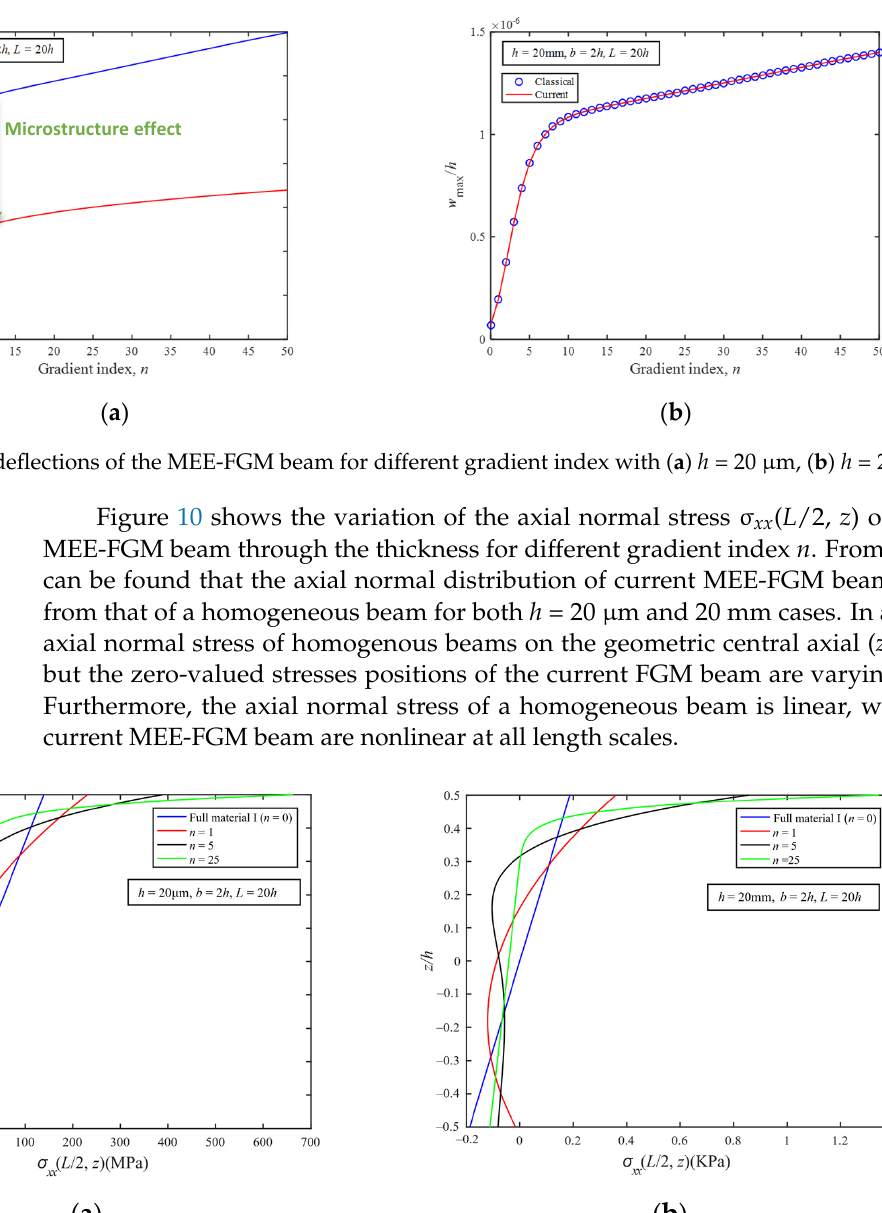
index n for h = 20 μ m and 20 mm, respectively. From Figure 9a, it can be seen that the